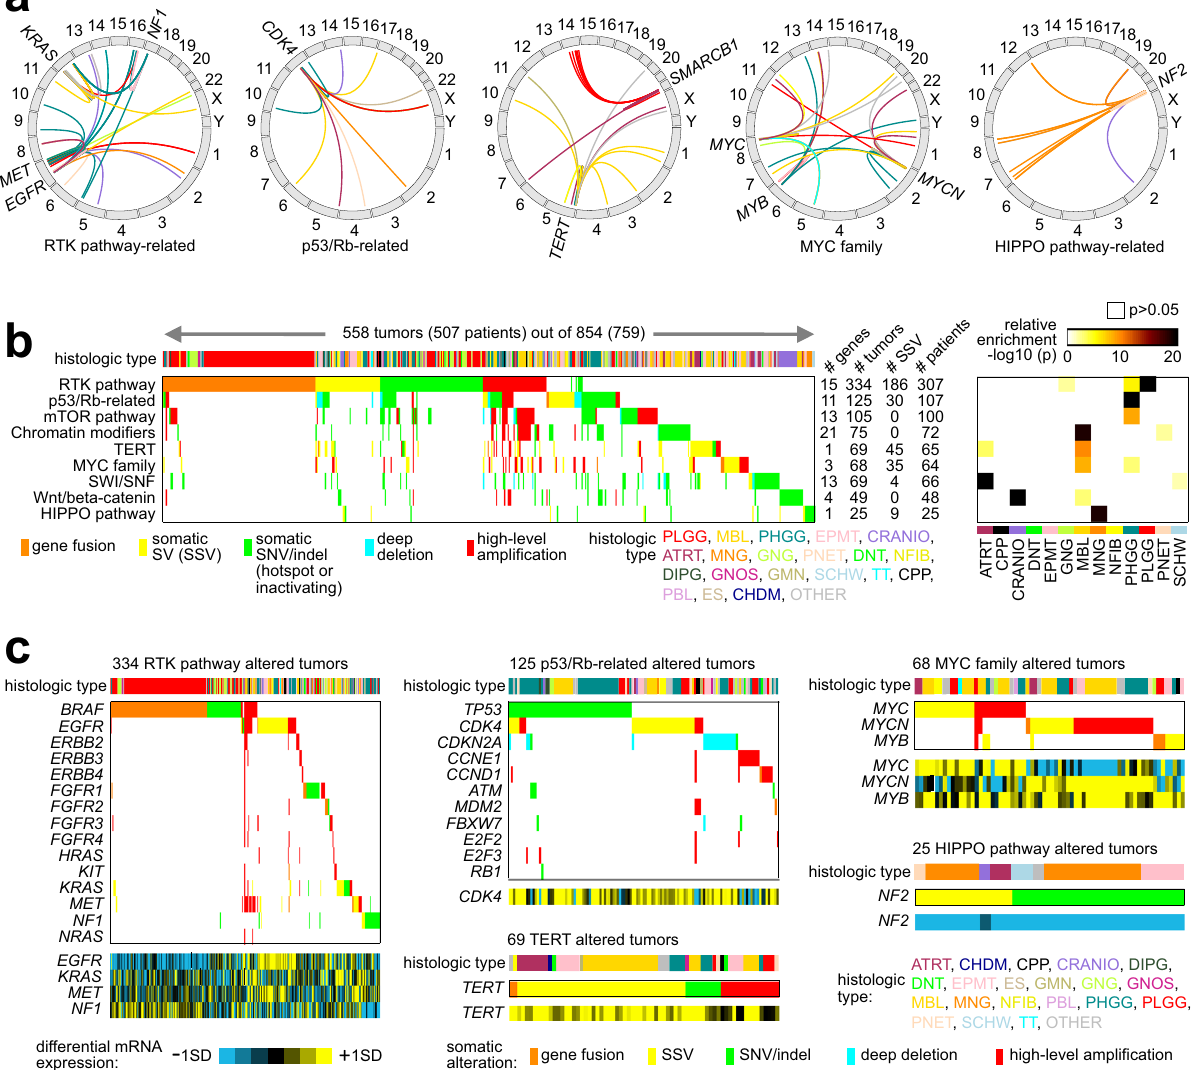
Fig. 5 SSVs associated with key oncogenic or tumor-suppressive pathways. a Genomic rearrangements (represented in circos plots) involving Receptor Tyrosine Kinase (RTK) pathway-related genes ( KRAS , MET , EGFR , NF1 ), p53/Rb-related genes ( CDK4 ), TERT , SWI/SNF ( SMARCB1 ), MYC family genes ( MYC , MYCN , MYB ), and HIPPO pathway-related genes ( NF2 ). SSV events are colored according to tumor type, as indicated. b Pathway-centric view of somatic alterations in pediatric brain tumors (representing 558 CBTTC tumors and 507 patients with at least one somatic alteration in the indicated pathways), involving key pathways and genes previously annotated across multiple cancer types based on domain knowledge 19,21,36,37 . Panel on the right represents the signi fi cance of enrichment (one-sided Fisher ’ s exact test) of gene alteration events for each pathway within any particular tumor type versus the rest of the tumors (focusing on the 13 tumor types with the most tumors). c For the pathways from b that also involve at least one SSV event, somatic alteration events involving each gene included in the pathway are represented. For SSV-impacted genes the corresponding differential mRNA expression patterns are shown. For a , b , events are colored according to the type of somatic alteration: gene fusion, SSV (for oncogenes, breakpoint falling with 1 Mb of gene and associated with expression >0.4 SD from median for the given tumor; for tumor suppressors, breakpoint falling within the gene body and expression < − 0.4 SD), SNV or indel (for oncogenes, SNV within hotspot residue 49 ; for tumor suppressor genes, SNV within hotspot residue or inactivating mutation by indel/nonsense/nonstop), and deep deletion or high-level ampli fi cation (respectively approximating total copy loss and copy levels more than 2× greater than that of wild-type, based on thresholded